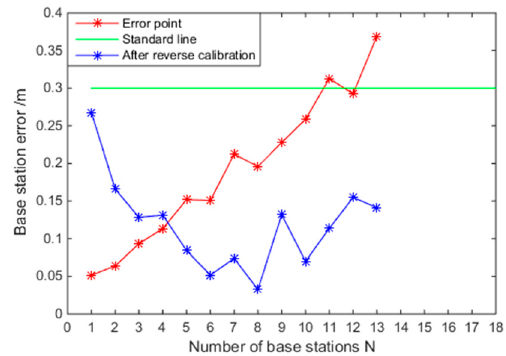
Figure 16. Comparison chart after bidirection calibration and only forward calibration.